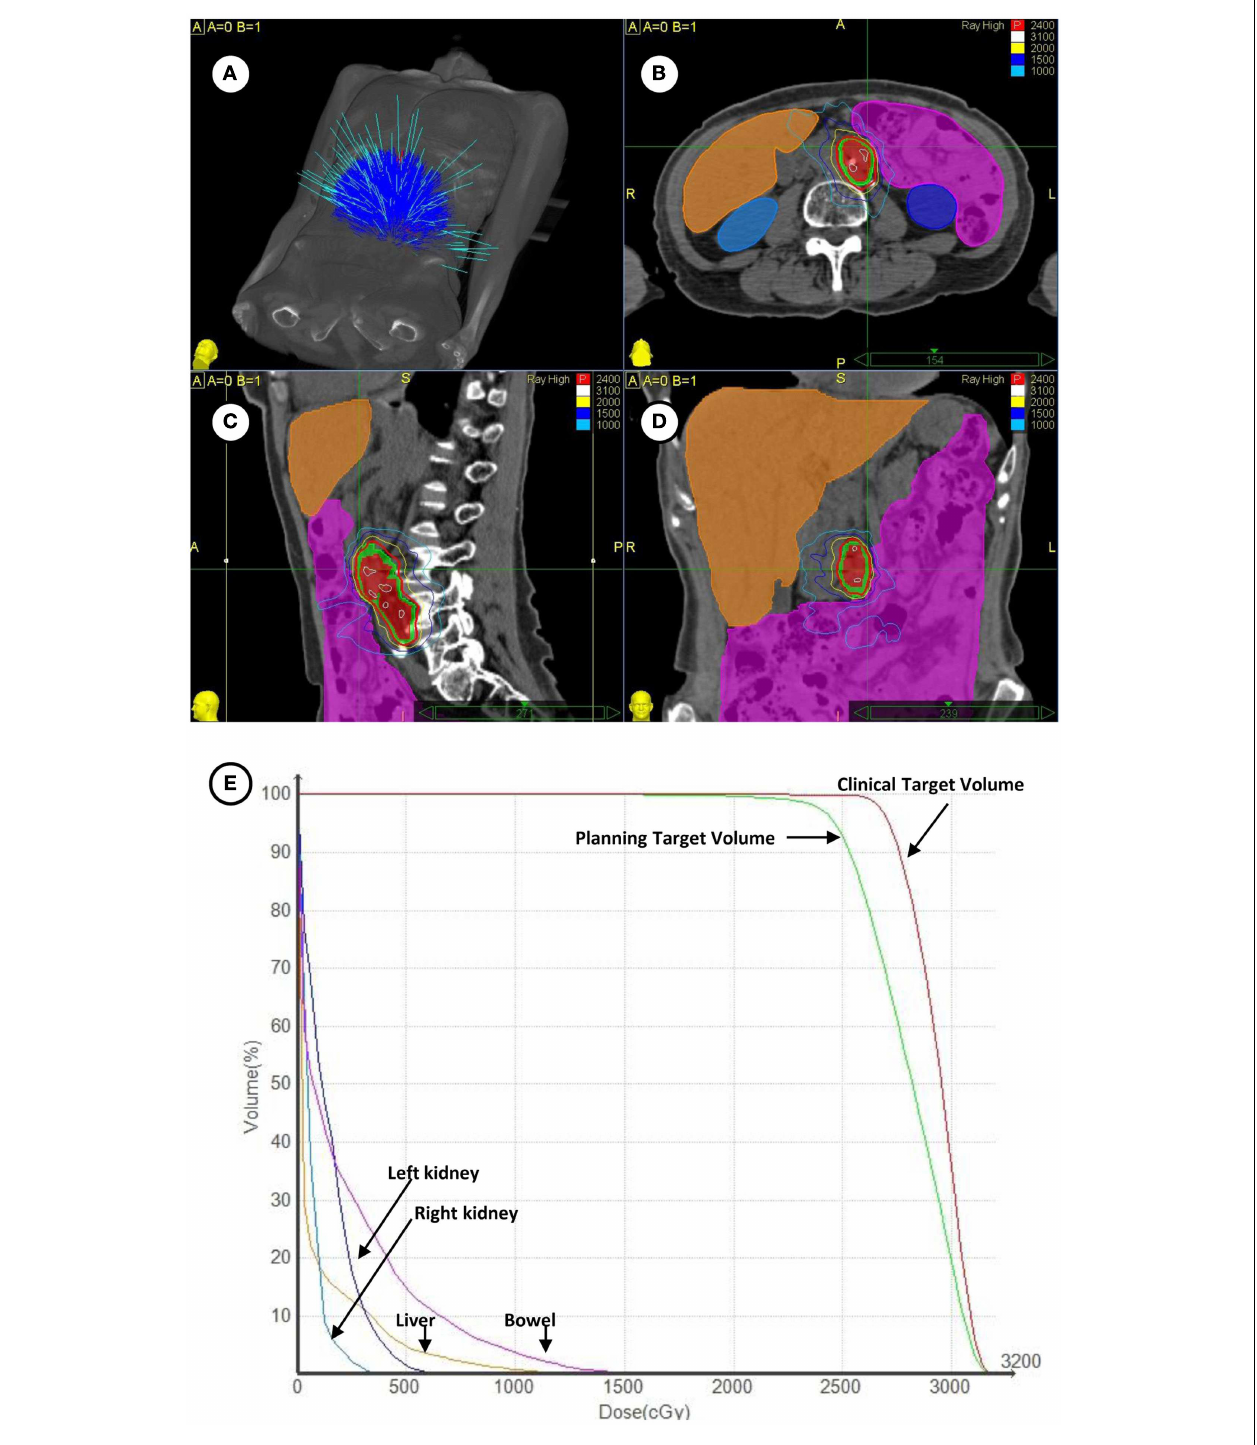
volume (green shaded volume) are contoured.The 24Gy prescription isodose is highlighted in red and a 10Gy isodose is outlined in light blue. Contouring of the bowel (magenta), liver (orange), right kidney (light blue), and left kidney (dark blue) is shown. (E) Plotted are corresponding radiation dose-volume histograms for clinical targets and organs